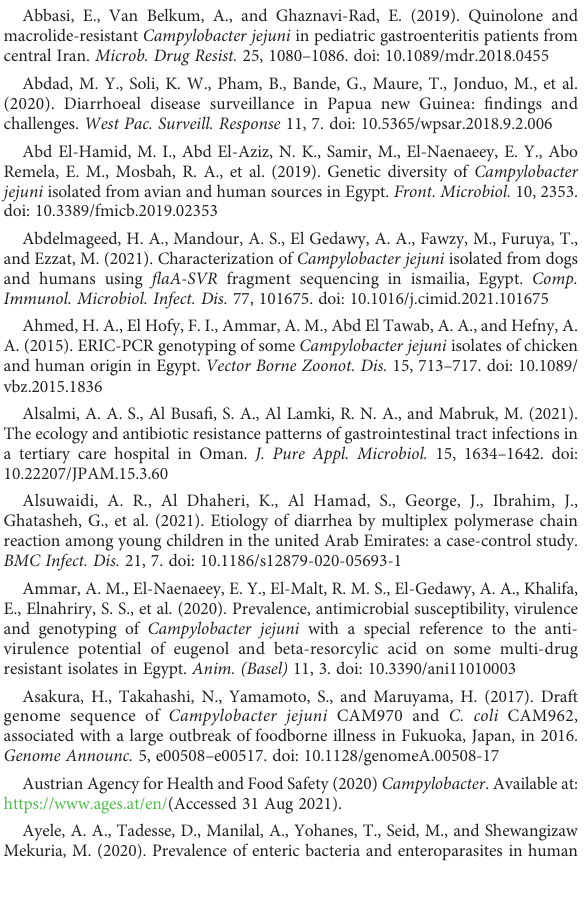
SUPPLEMENTARY FIGURE 1 Impact of COVID-19 on the reported incidence of campylobacteriosis. Reported incidence are presented as per 100,000 population. The average incidence between 2014-2019 was lower than that in 2020 due to COVID-19 pandemic in most of the countries, except France, Lithuania and